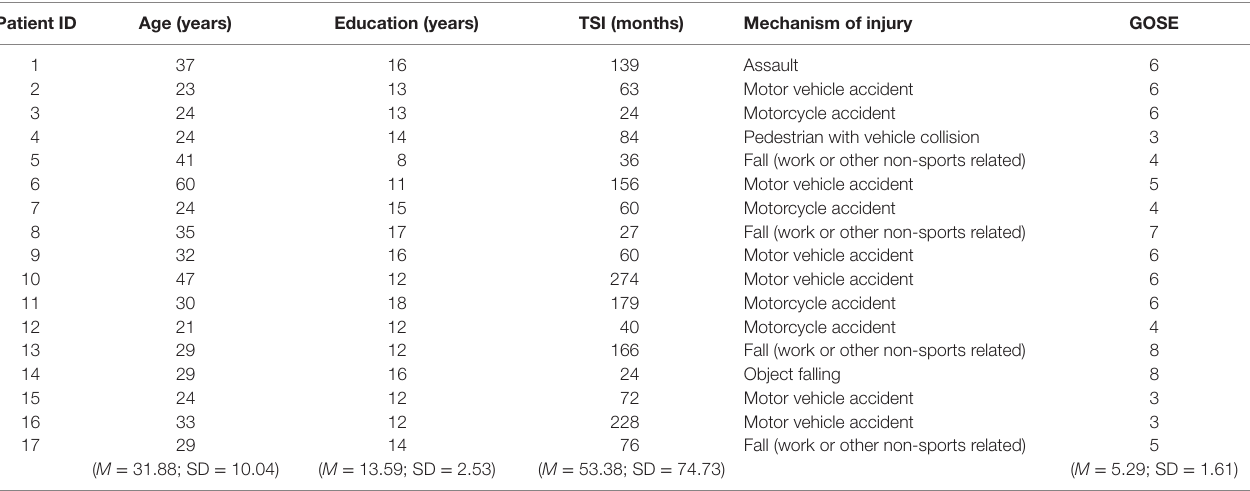
TaBle 1 | Demographic information of the TBi patient